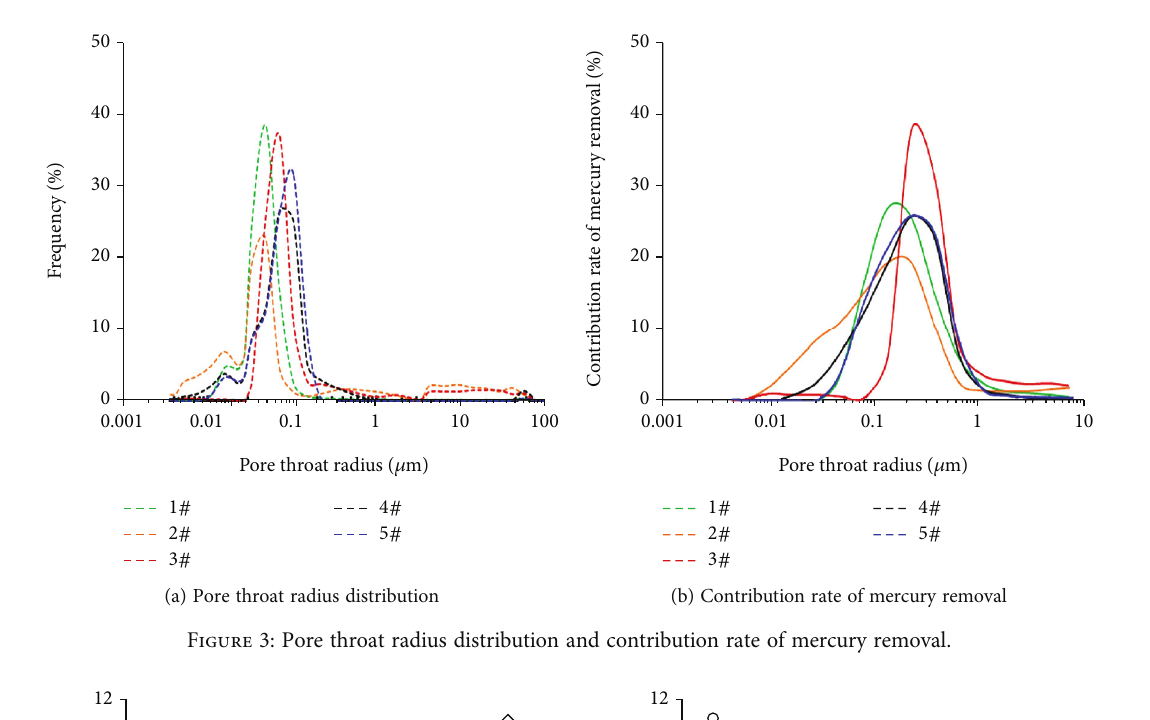
Figure 3: Pore throat radius distribution and contribution rate of mercury removal.